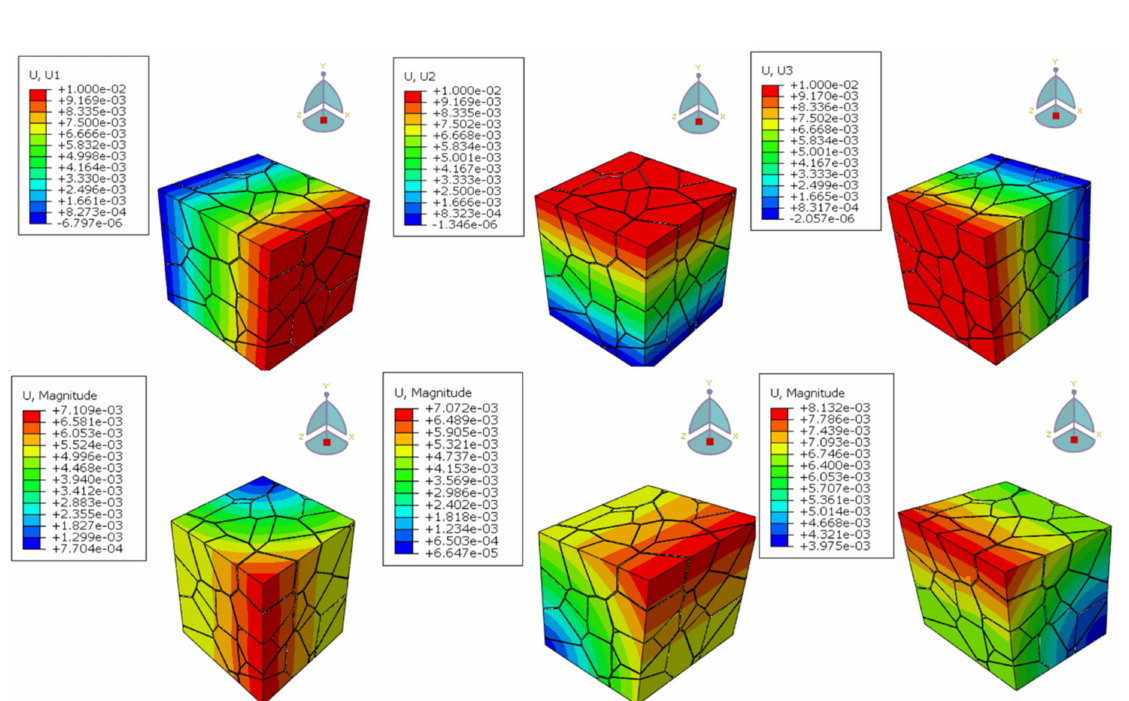
Figure 13. Deformation of 100-grain Al 2 O 3 ceramic material under the boundary